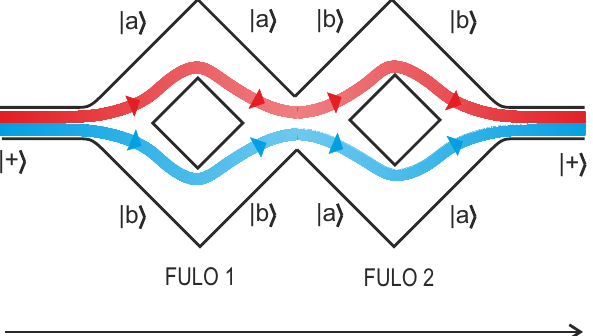
Figure 2. FULOs change the hidden variables. A full-loop Stern–Gerlach apparatus (FULO) maps the spin hidden variables onto a particle trajectory. However, the FULO does not preserve the values of the hidden variables as shown by the conceptual experiment depicted here, where a FULO oriented along the x axis is followed by a FULO oriented opposite to the x axis. If the initial state of the spin is an equal superposition of “up” and “down” along the x axis, namely | + (cid:105) = ( | a (cid:105) + | b (cid:105) ) / trajectory is as depicted: if the trajectory in the first FULO is in the a -arm, it is in the b -arm in the second (which is flipped by 180 degrees) and vice versa. A possible interpretation is that the FULO has changed the spin hidden variable for x , even though it is an identity transformation that does not change the quantum